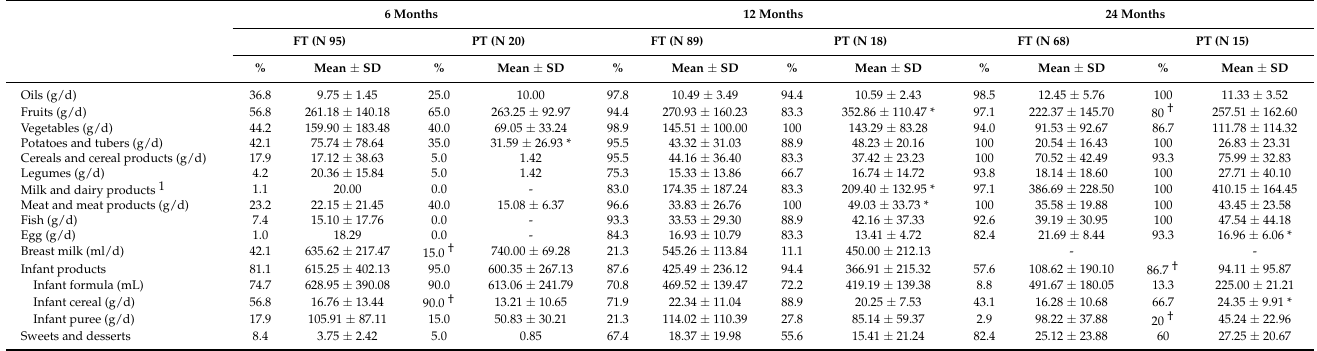
Table 2. Differences in food consumption between Full-term (FT) and Preterm (PT) toddlers from 6 to 24 months.